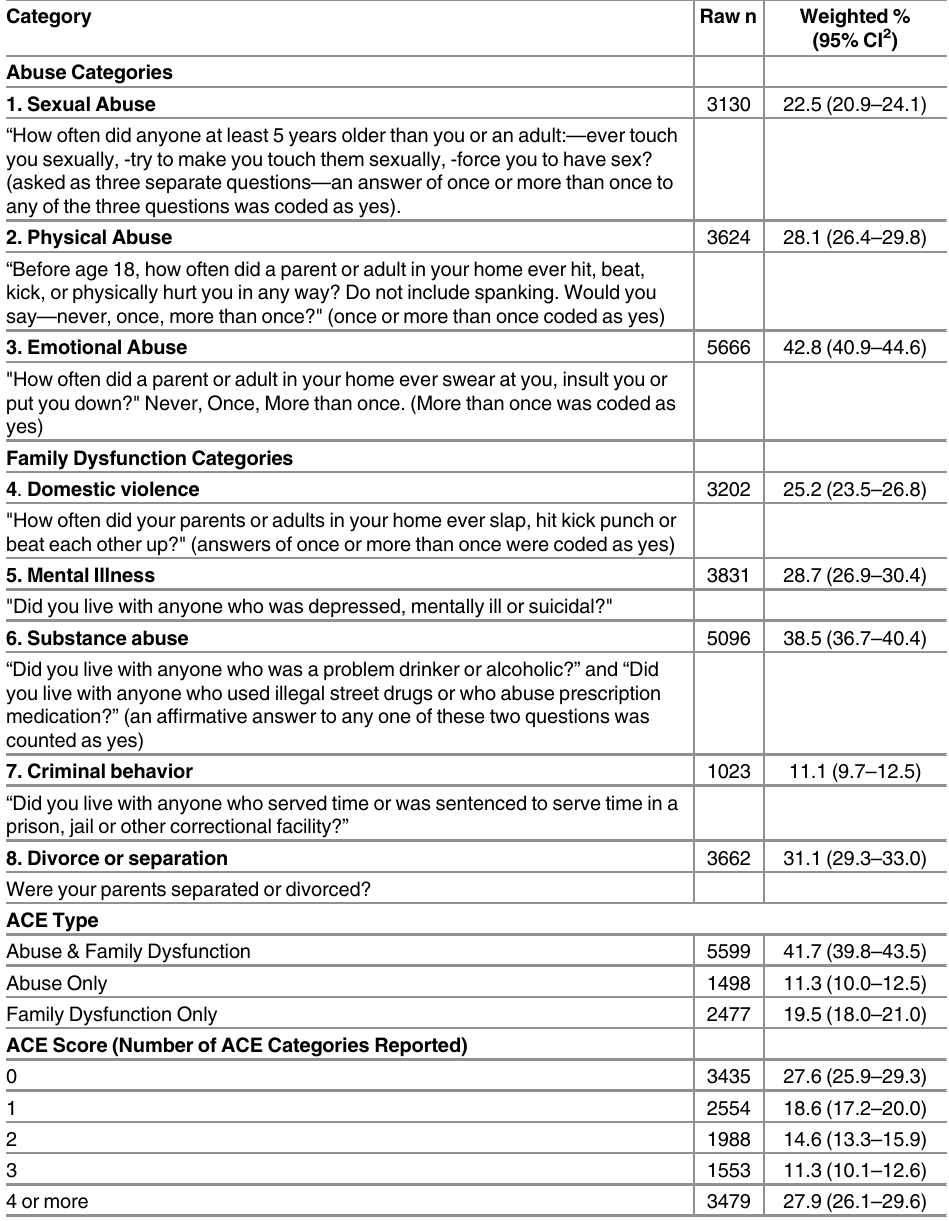
Table 1. Adverse Childhood Experience (ACE) 1 Prevalence Estimates by Category, Type and ACE Score (Sample n = 13,009).